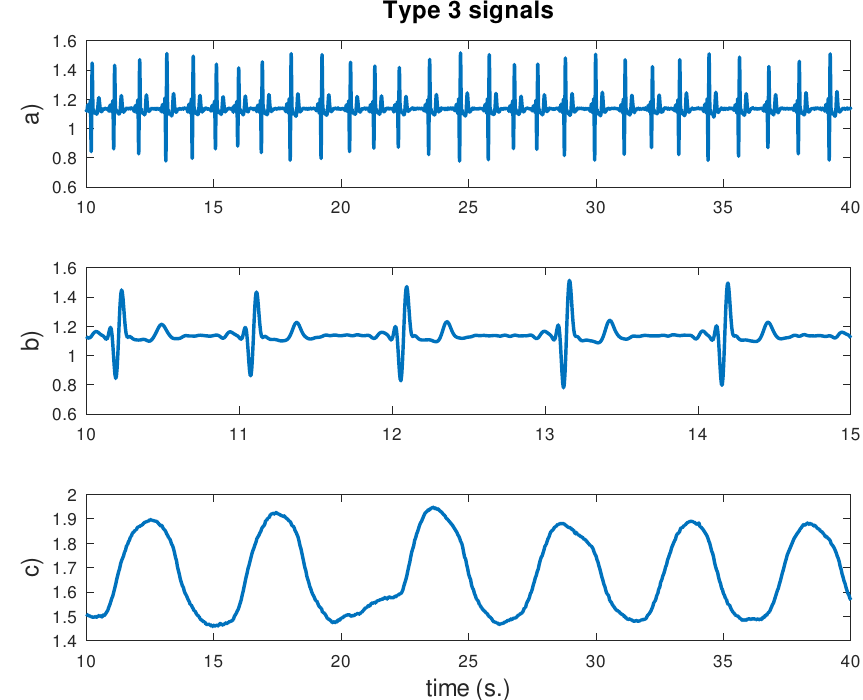
Figure 11. ECG and breathing signals for 30 s. during the first phase of the experiment. From top to bottom: ( a ) ECG signal; ( b ) ECG signal detail for 5 s; ( c ) breathing signal. Vertical units are in converter units.